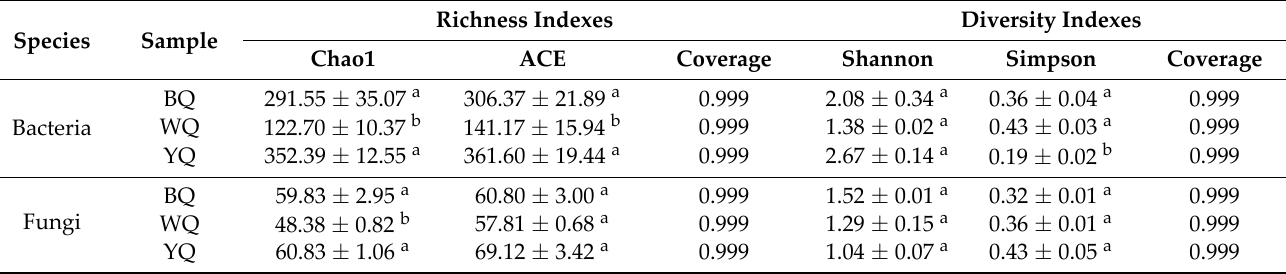
Table 2. Species α ‑diversity indexes among three Daqu